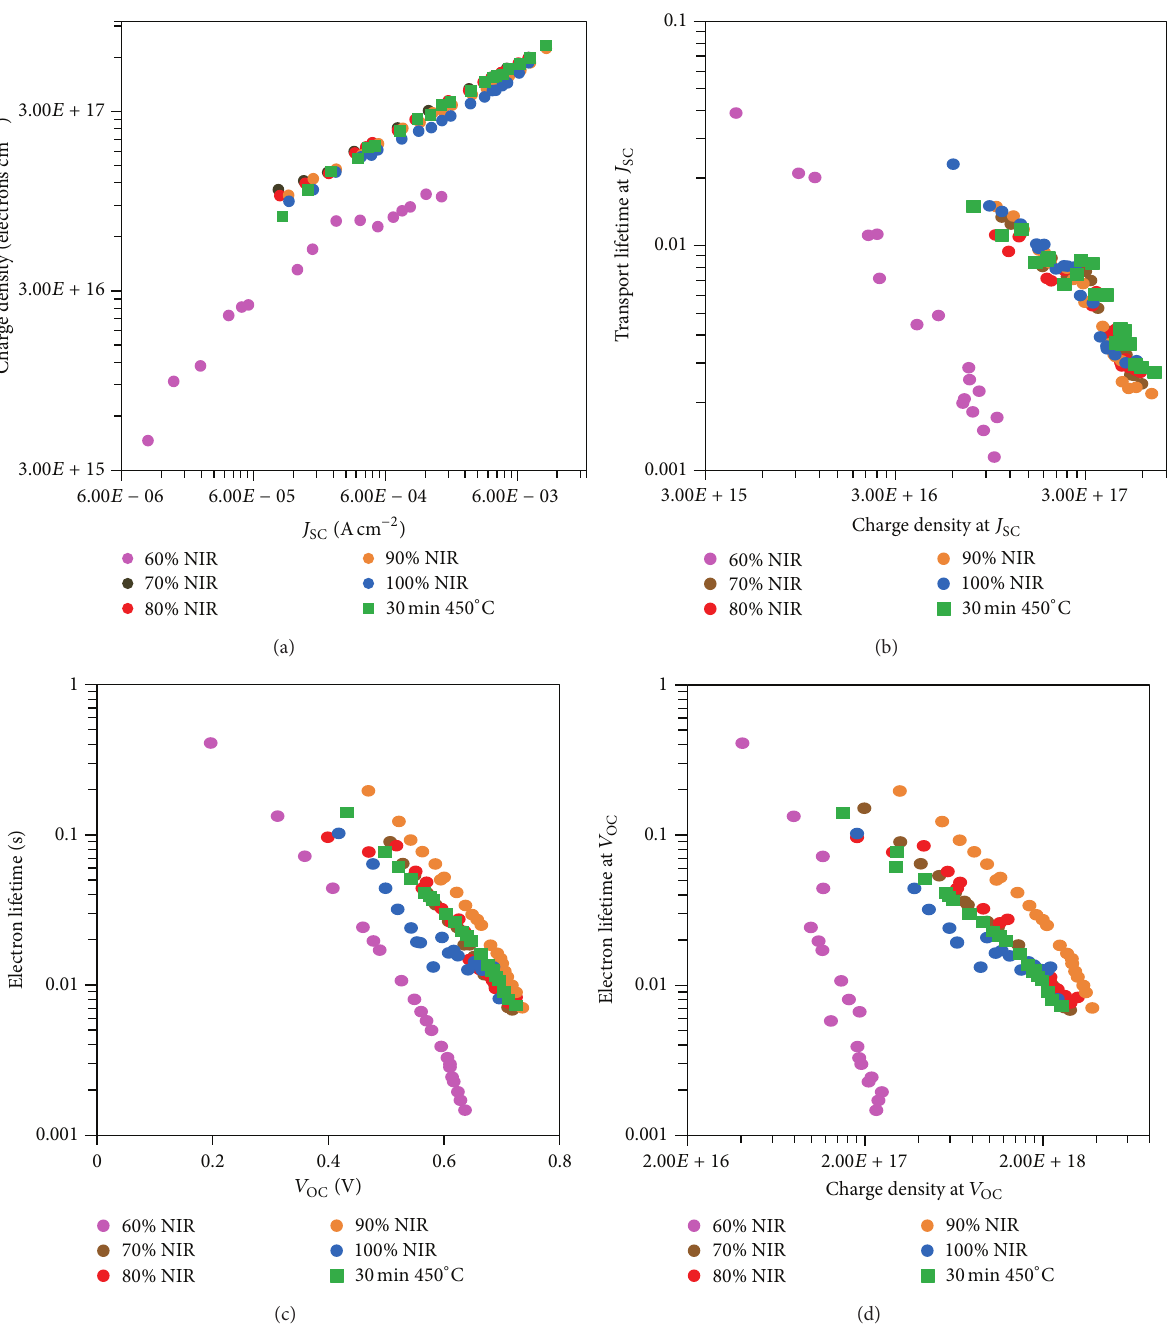
Figure 6: Optoelectronic transient measurements for (a) charge density versus 𝐽 electron lifetime versus 𝑉